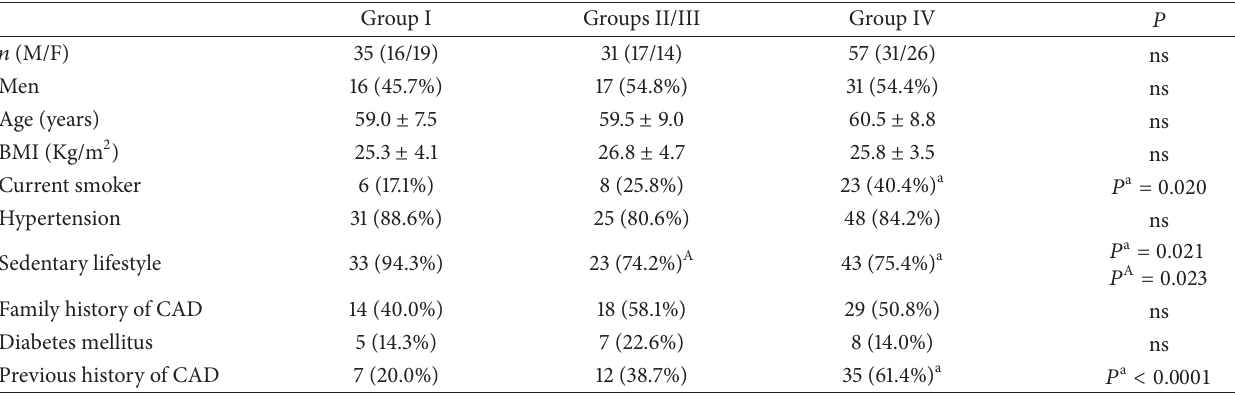
Table 1: Baseline patients’ characteristics.